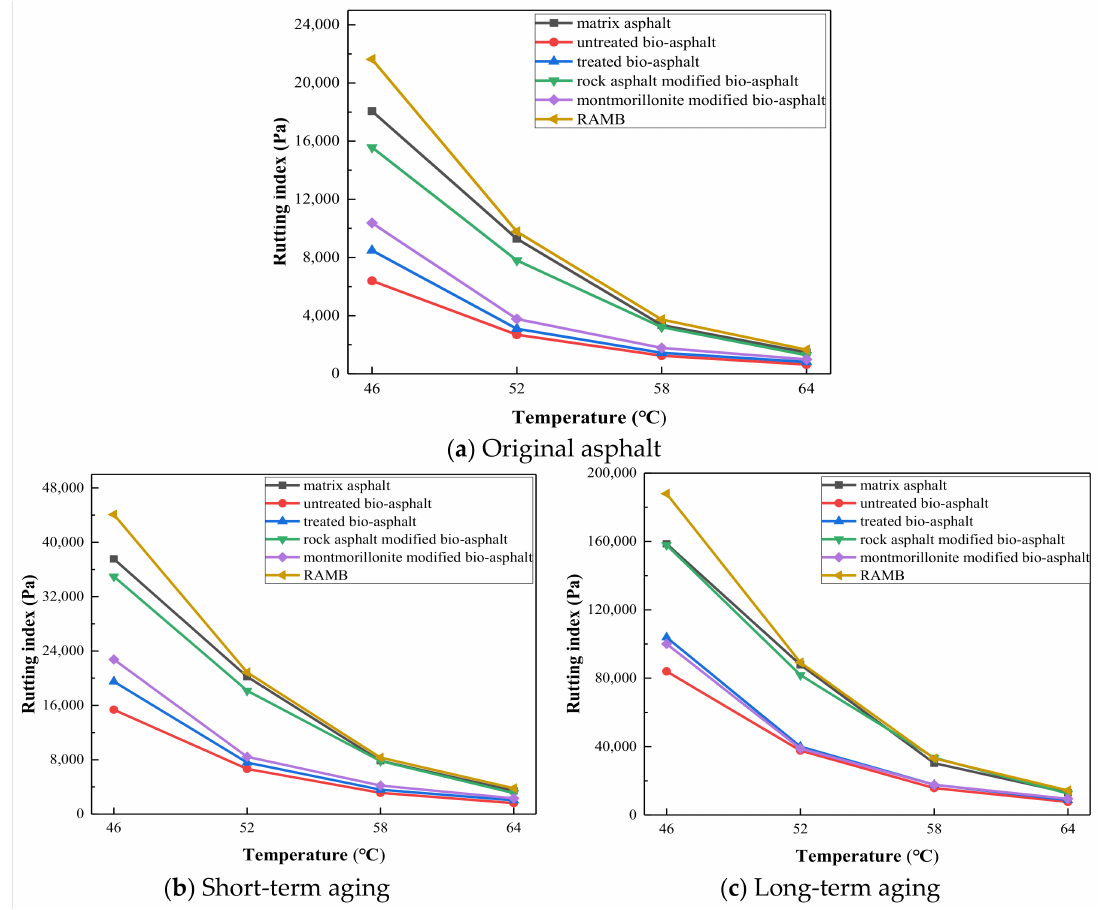
Figure 10. Rutting indexes of six